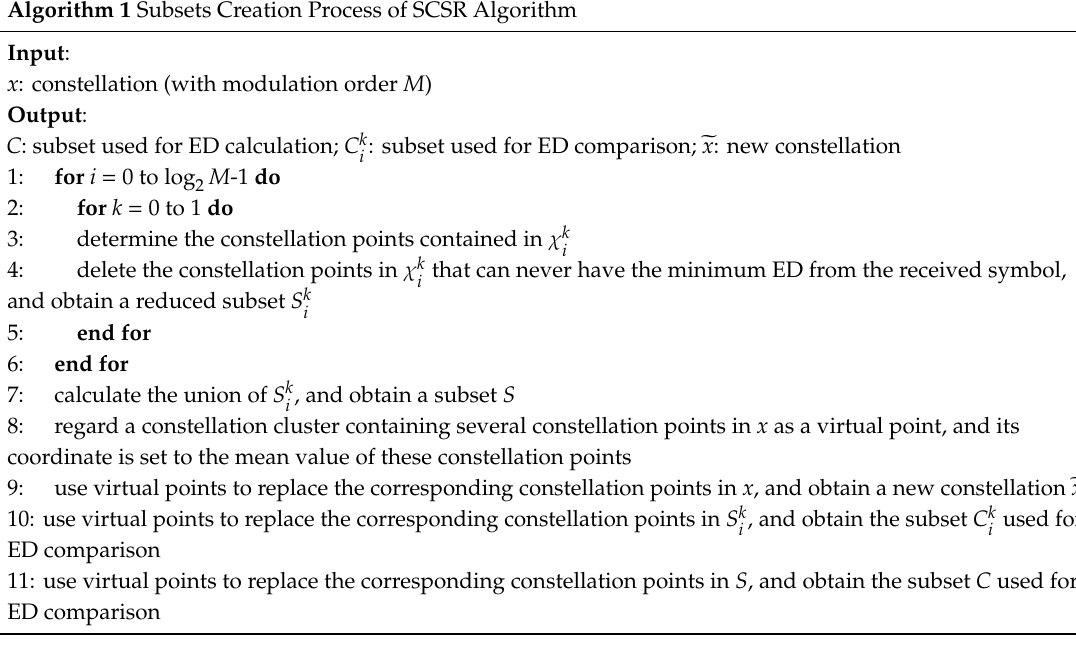
Algorithm 1 Subsets Creation Process of SCSR Algorithm